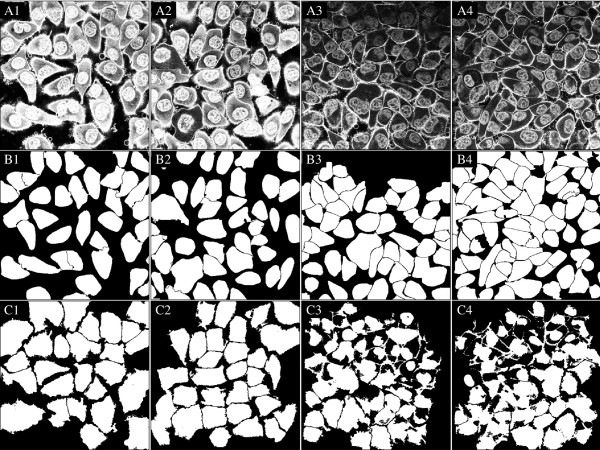
A batch processing of two data sets from two experimental conditions, as described in Example 12. The data is visualized for plane seven. A1-A4) Data set one and two in the two conditions. B1-B4) Segmentation using CELLSEGM. C1-C4) Segmentation using CELLPROFILER. For the strongly stained cells, CELLPROFILER provides a larger segmentation than CELLSEGM. For the weakly stained cells, CELLPROFILER is missing large cell fractions compared to CELLSEGM, probably due to uneven illumination. However, a correction of the uneven illumination pattern uneven did not improve the results (data not shown). For visualization, the objects segmented in CELLPROFILER where eroded by one voxel to highlight the contours.